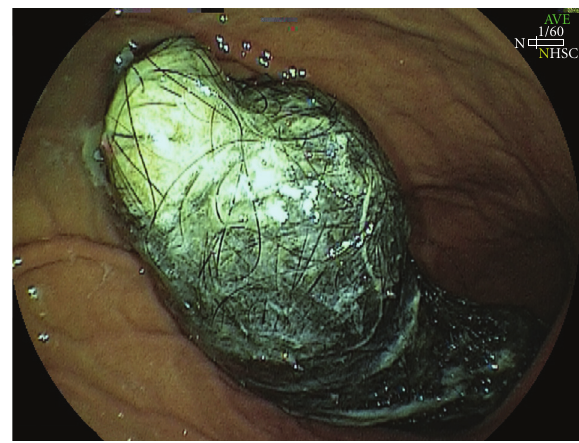
Figure 2: Endoscopic image of an intragastric trichobezoar.